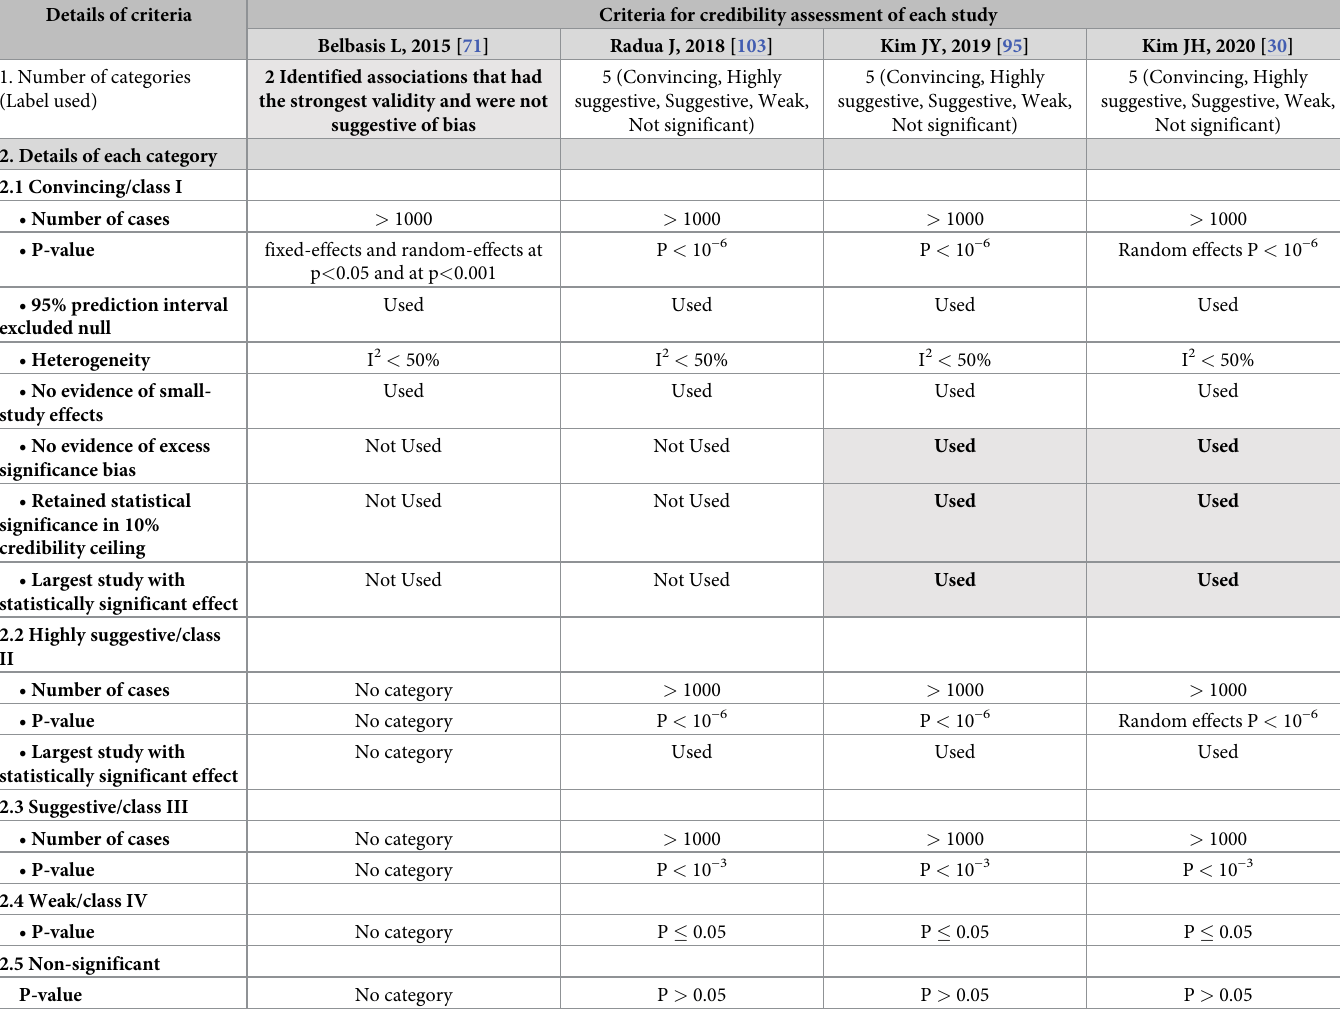
� Of 7 umbrella reviews published Top-100 ranking journals group that included in this study, 4 studies used the criteria of credibility assessment to assess the certainty of the